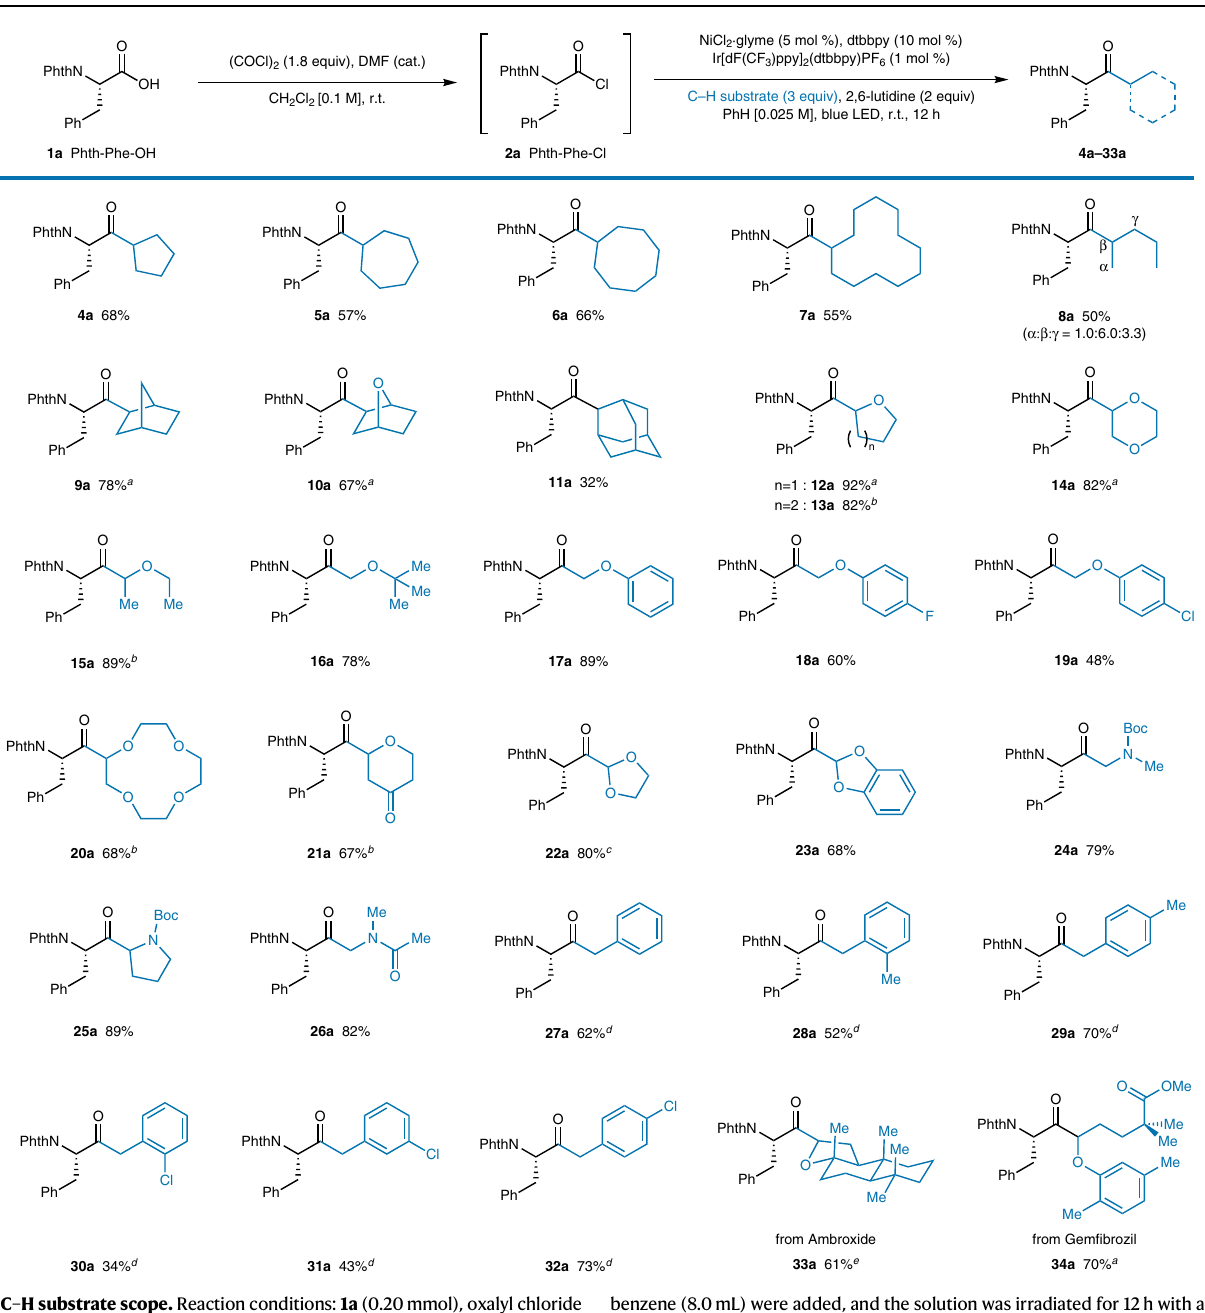
Fig. 3 | C – H substrate scope. Reaction conditions: 1a (0.20mmol), oxalyl chloride (1.8 equiv), DMF (cat., 0.2 μ L), and CH 2 Cl 2 (2.0mL). After evaporation of the remaining solvent, NiCl